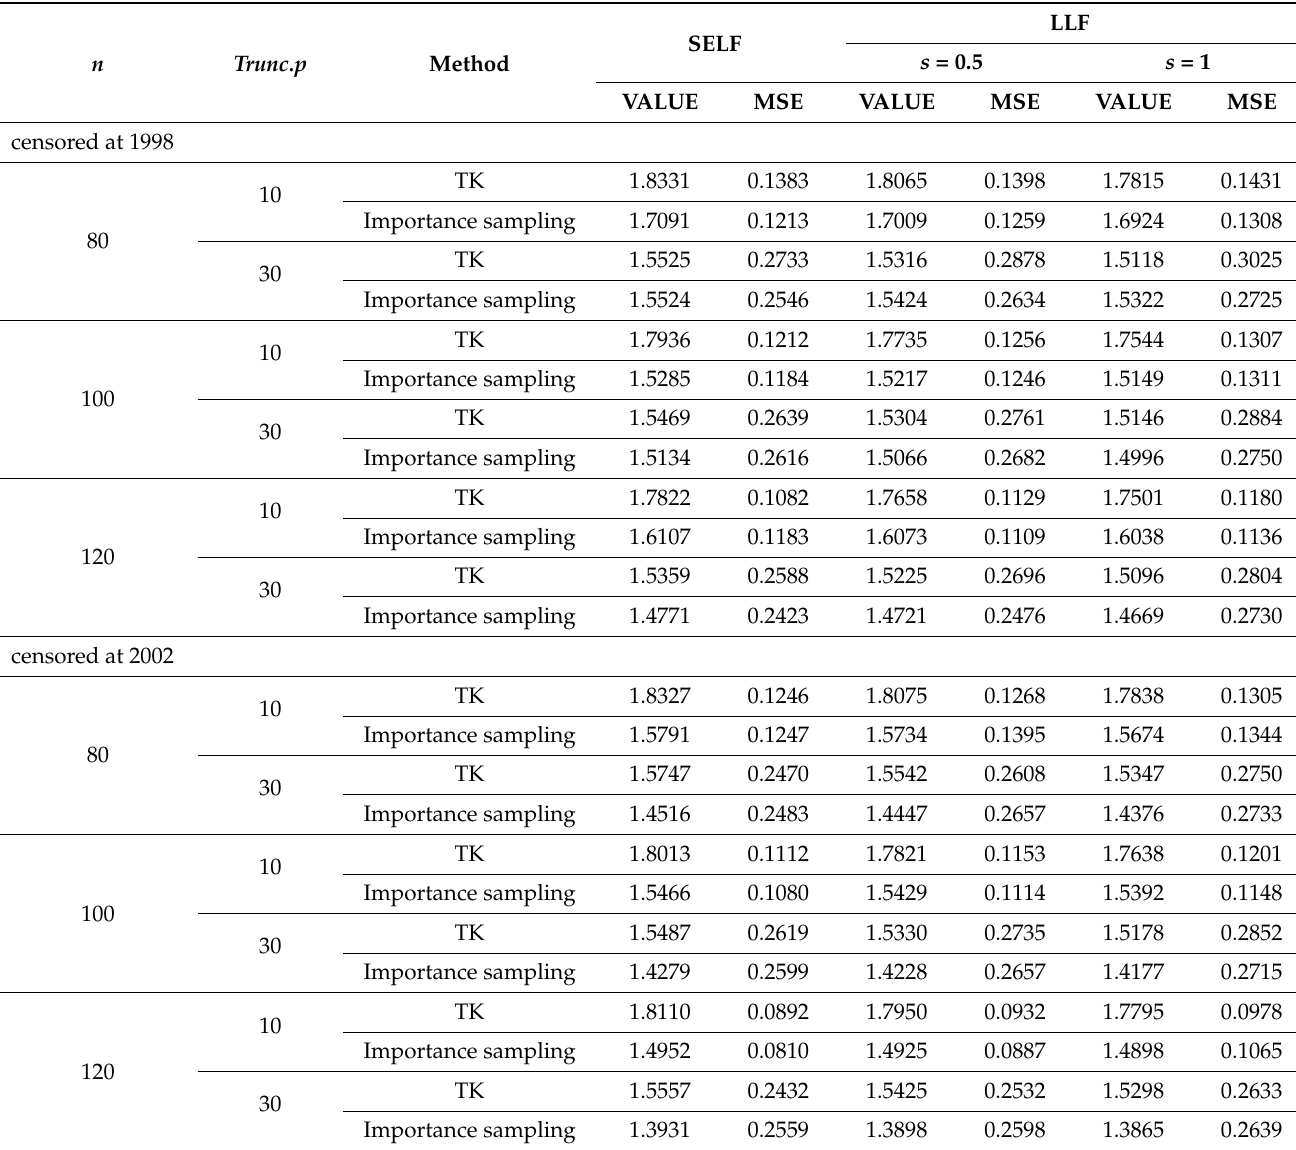
Table A2. The results of non-informative Bayesian estimates for λ using TK approximation and importance